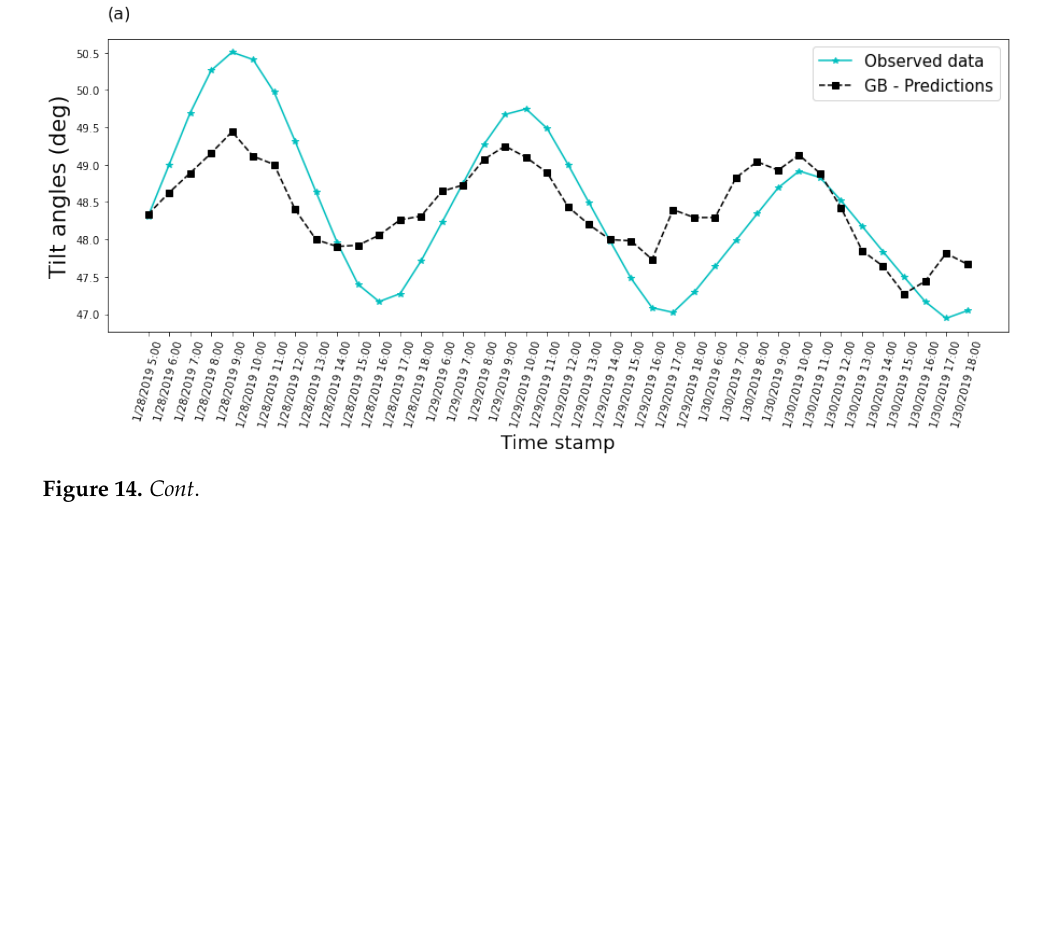
Figure 13. LSTM nowcast results for a random selection of ( a ) 3 days and ( b ) 31 days of testing dataset.